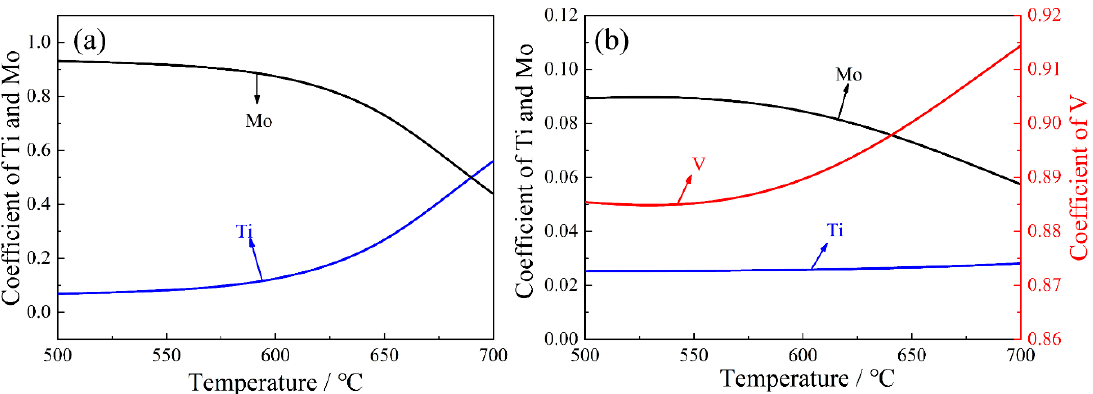
Figure 8. The formula coefficient of ( a ) Ti x Mo y C and ( b ) Ti x Mo y V z C in ferrite as a function of temperature. Figure 9 is the curve of the volume fraction of precipitation in ferrite with temperature.